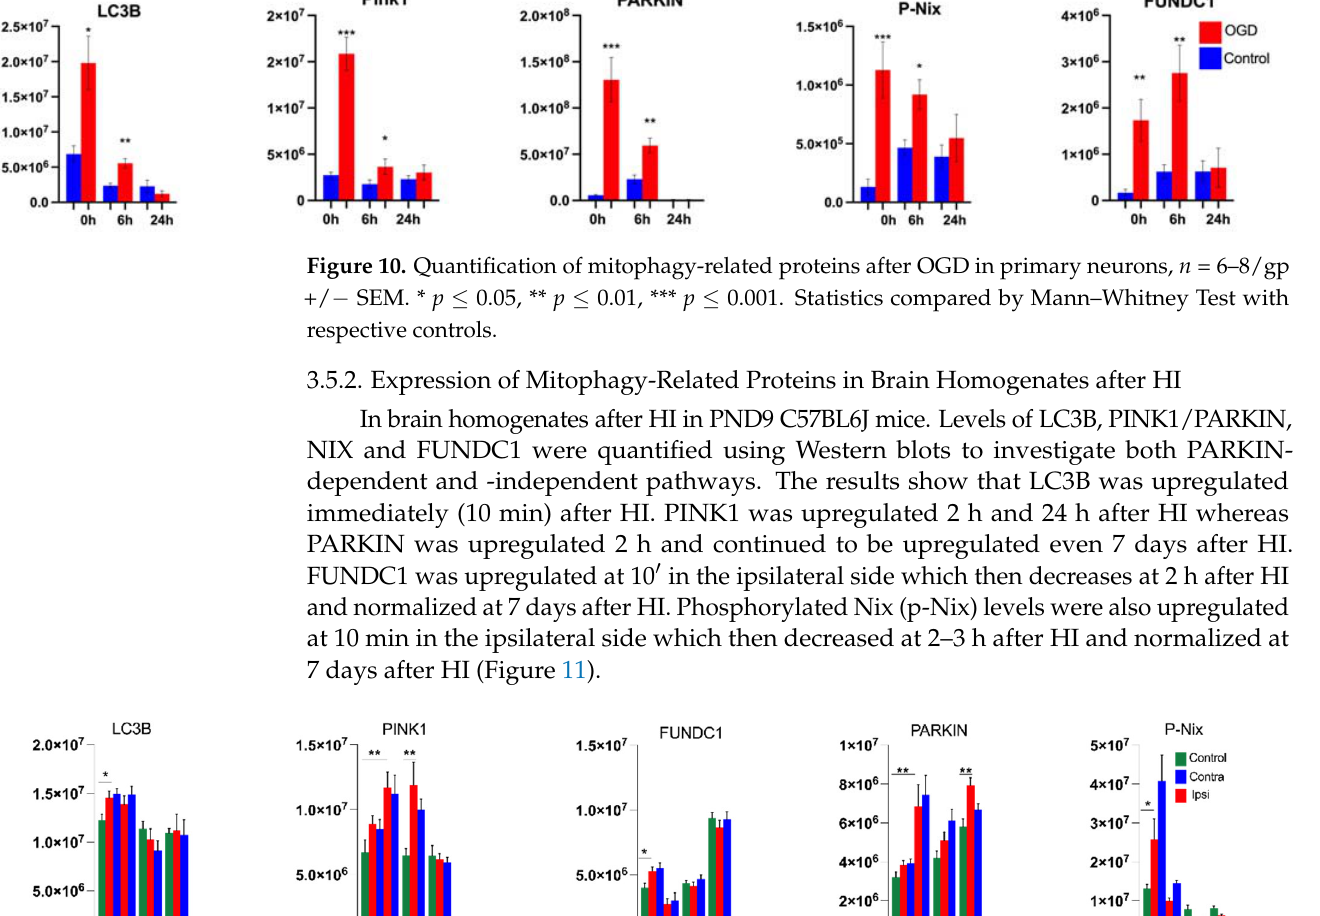
Figure 9. RT ‐ PCR of mitophagy genes Pink1, Parkin, Nix, FUNDC1. N = 6 +/ − SEM in duplicate. * p ≤ 0.05, ** p ≤ 0.01. Statistics compared by Mann–Whitney Test between the control and respective ipsilateral hemisphere.